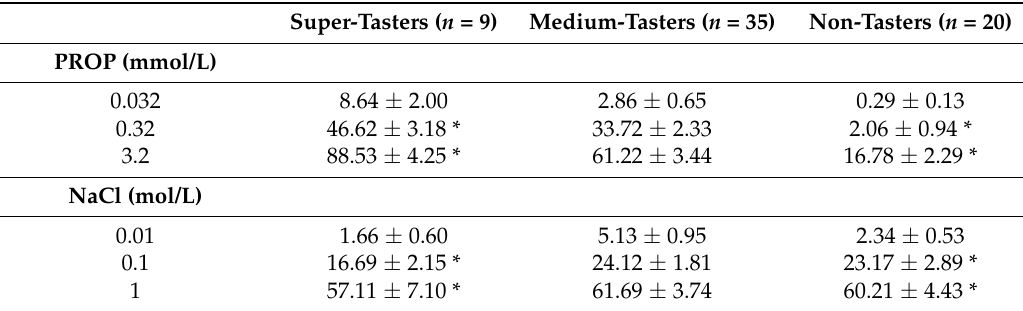
Table 1. Ratings of perceived taste intensity in response to three concentrations of PROP and NaCl in the taster